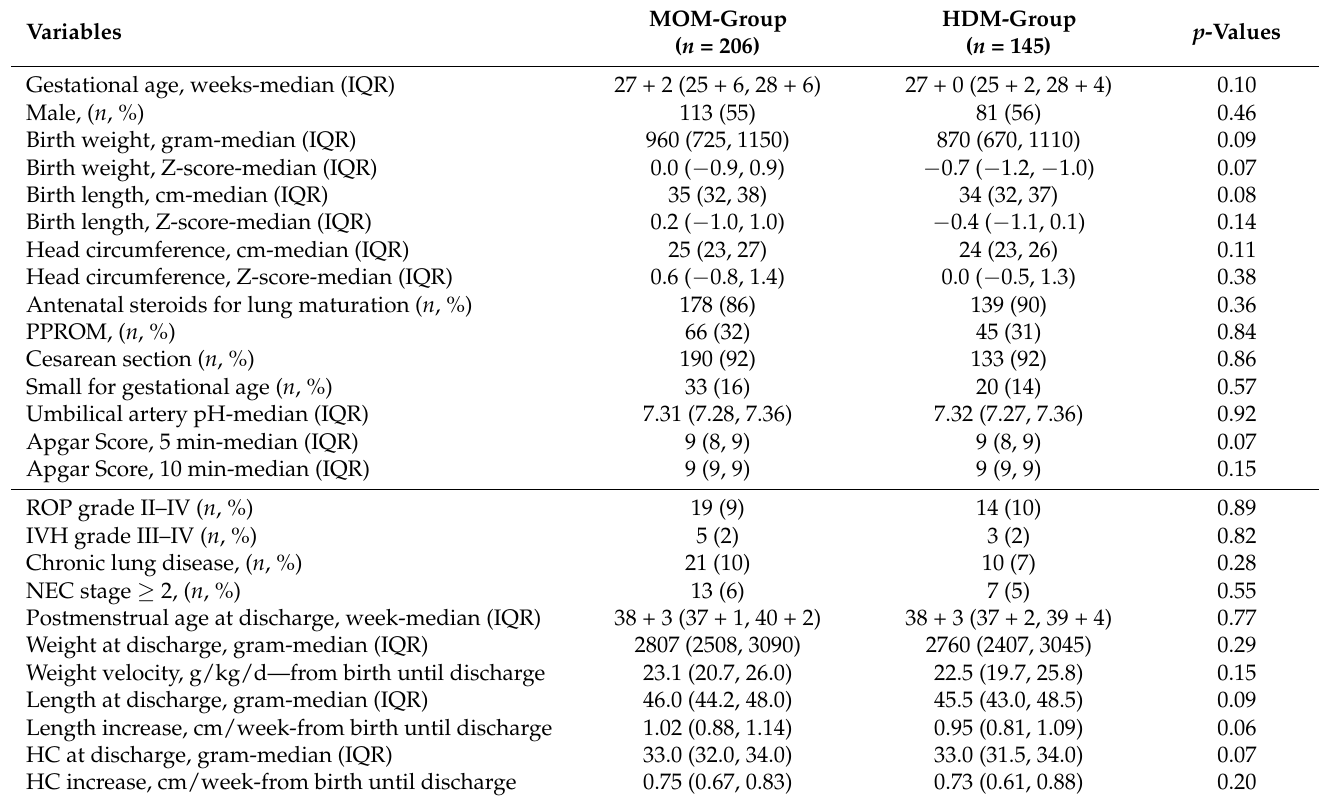
Table 1. Baseline characteristics, growth velocity, and short-term outcome